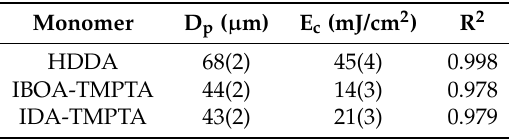
Table 3. Calculated critical energies (E c ) and penetration depth (D p ) of the evaluated photocurable monomers with 28 vol.% of 8YSZ.